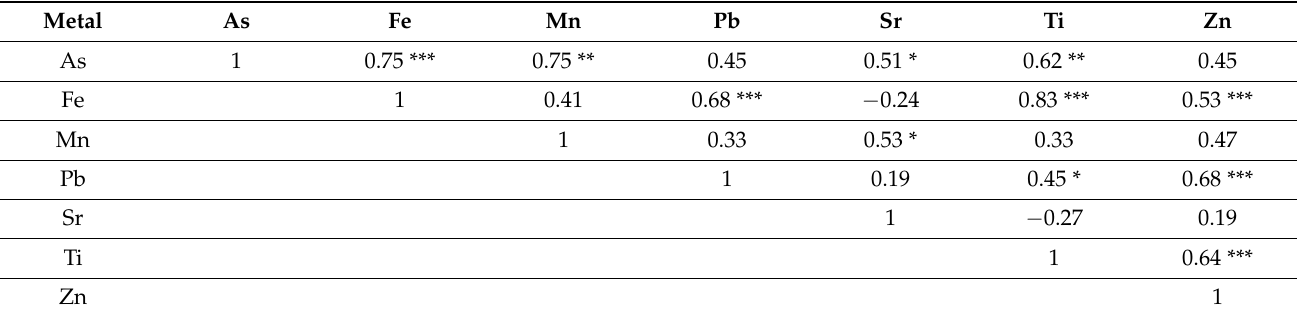
Table 5. Matrix of correlation coefficients among heavy metals.